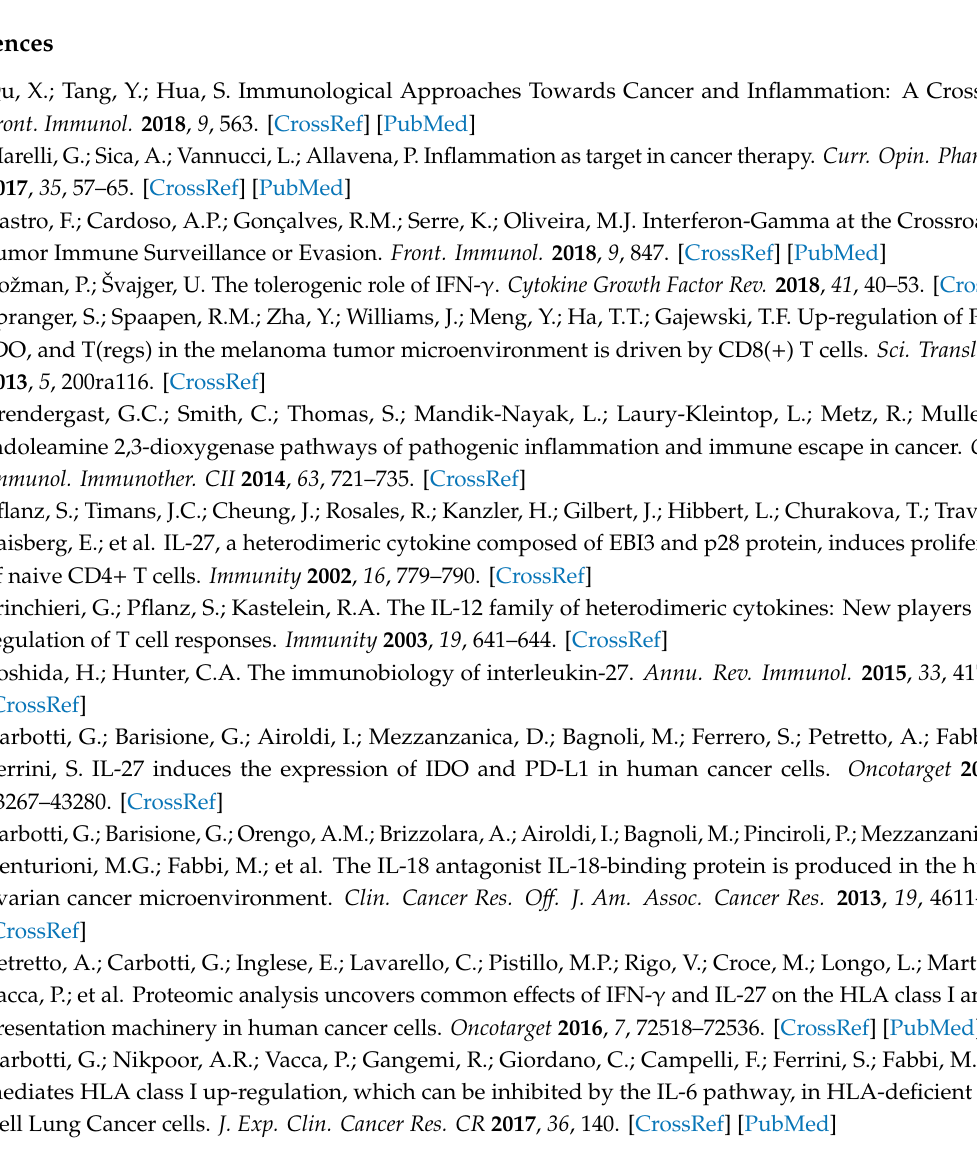
fluids. P value not significant, Figure S6: Soluble GBP1 is present in the liquid phase but not in the vesicular fractions of ascites A32, Figure S7: Densitometry readings or intensity ratio of the relevant bands for all Western blot figures. Whole blots showing all the bands with all molecular weight markers (GE RPN 800E) are shown for each figure panel. Table S1: Anova and Student’s T test analyses of the selected 699 cytokine-modulated proteins of the SKOV3 secretome, Tabel S2: Anova analysis of clusters 3,6 of Figure 1, Table S3: Anova analysis of clusters 1,5-2,4 of Figure 1, Table S4: Lists of proteins of the Venn diagram of Figure 2A, Table S5: List of proteins of the fold-change heatmap of Figure 2B, Table S6: Distribution by tumor characteristics for EOC patients with evidence of